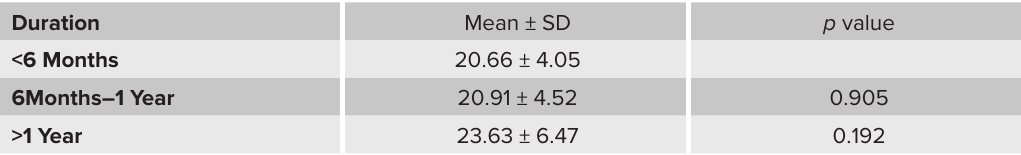
Table 5: Mean Comparison of Study Parameter across the Duration of